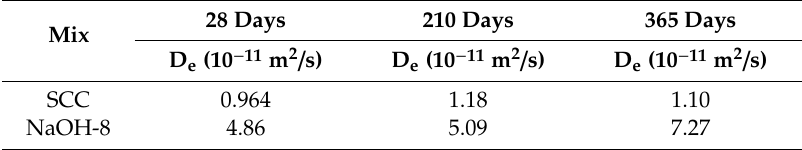
Figure 10. Chloride diffusion characterization of the larger batch series of SCC and NaOH-8 concrete specimens at ( a ) 28 days, ( b ) 210 days and ( c ) 365 days after casting. Table 7. Average effective chloride transport coefficient, D e , for the larger batch series of SCC and NaOH-8 specimens.